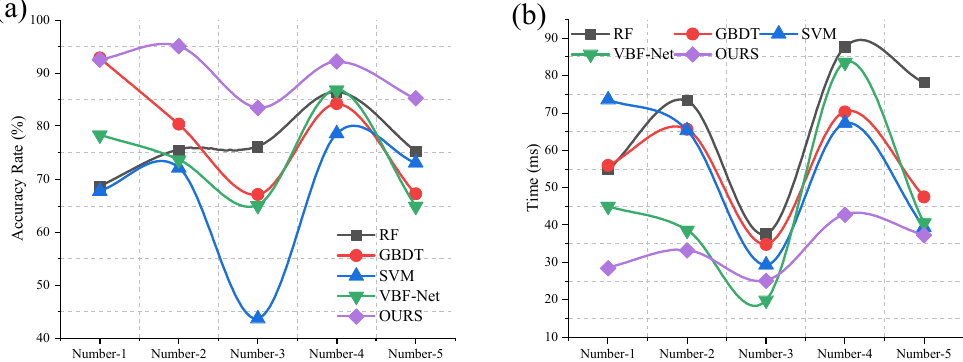
Figure 8. Processing results of different methods when processing sample data: ( a ) extraction accuracy; ( b )